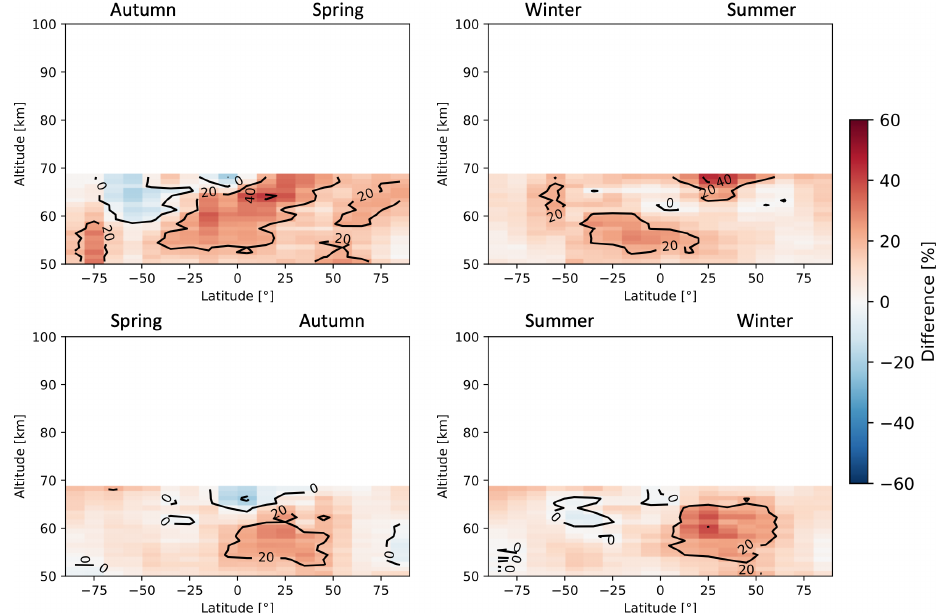
Figure A1. Seasonal zonal means of SMR–MIPAS OR-NOM relative differences averaged over the time period indicated in Table 2. The seasons are intended as the time between the solstice and the equinox.